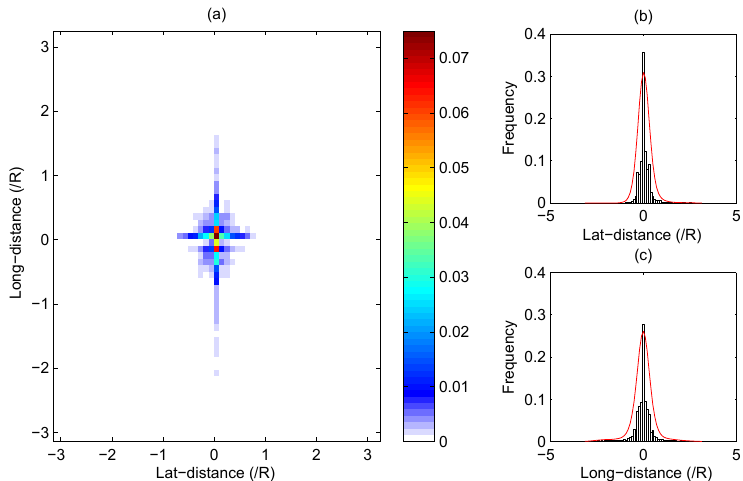
Figure 3. The distribution of the directed edge distances in the global ionospheric network. Panel (a) shows the distribution of edges against the latitudinal and longitudinal distances; panel (b) shows the distribution of edges against their latitudinal distances; panel (c) shows the distribution of edges against their longitudinal distances. The red curves delineate the distribution